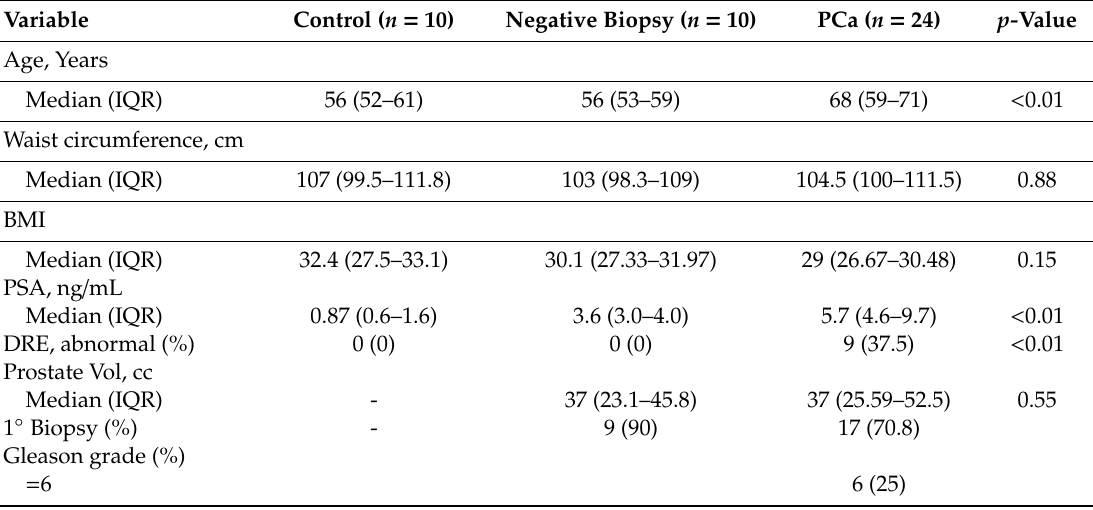
Table 3. Demographic and clinical characteristic of patients included in the study of urine EN2